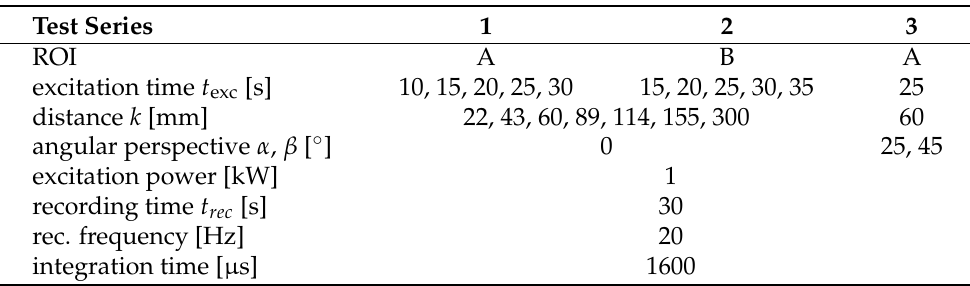
Figure 4. Schematic representation of the angular perspective with different offsets between the defect and the optical axis of the camera, α = 25 ◦ and β = 45 ◦ . Table 2. Overview of the parameters of every test series, compared with the measurement arrange- ments shown in Figures 3 and